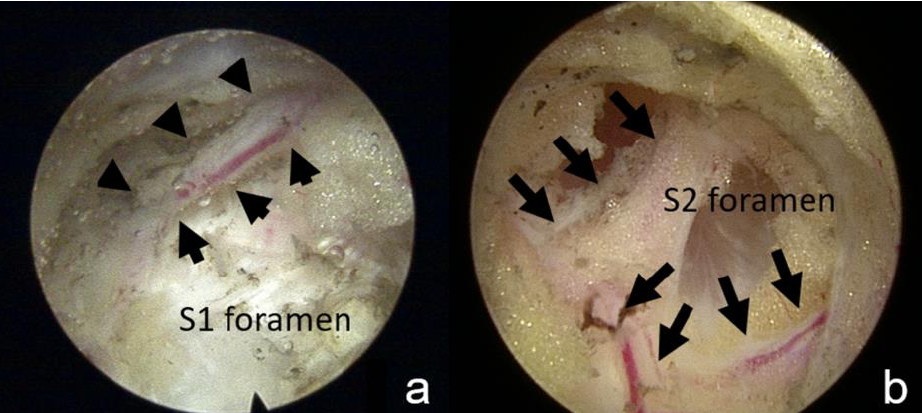
Figure 2. Foramen and sensory nerve under endoscopic view. ( a ) This endoscopic view demonstrates the S2 foramen and the exiting sensory nerve (arrow). ( b ) The sensory nerve is usually accompanied by blood vessels.